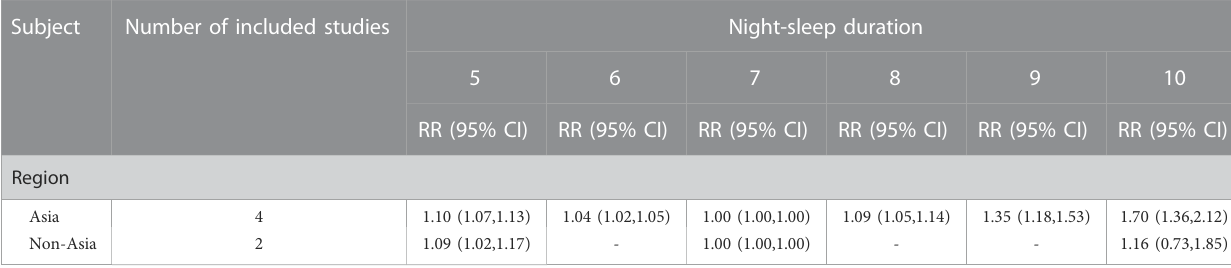
TABLE 2 Dose – response meta-subgroup analysis of sleep duration and risk of